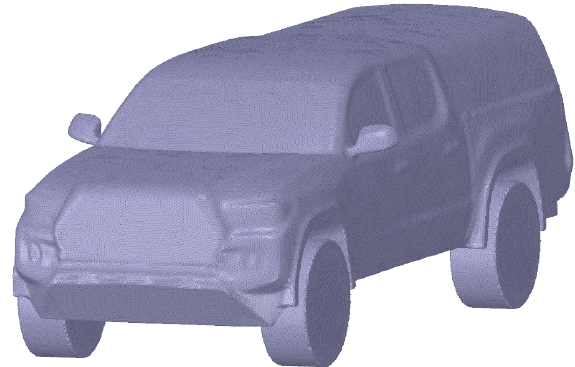
Figure 1. Truck model geometry replicating a 2016 Toyota Tacoma field